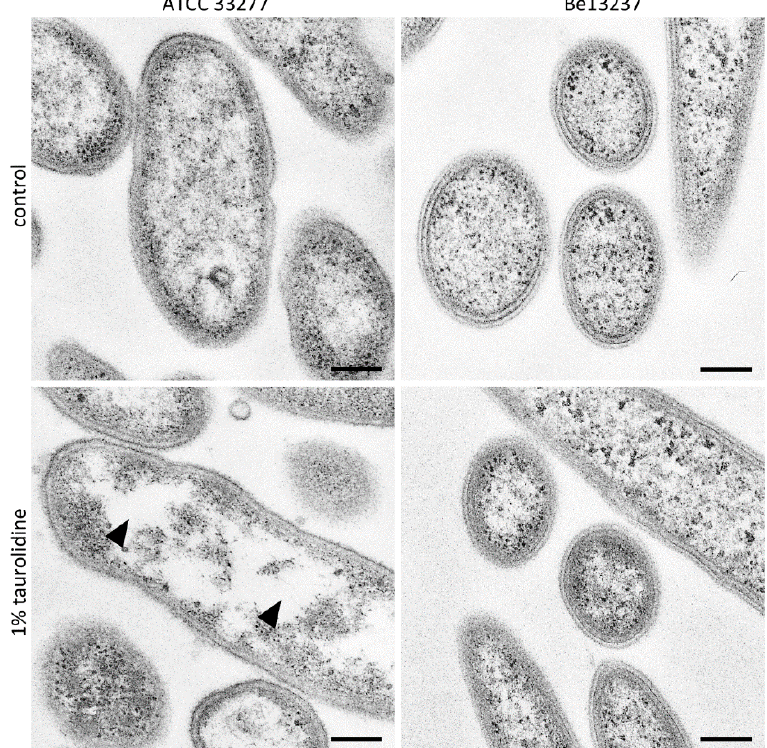
Figure 1. Transmission electron micrographs (TEM) images of Porphyromonas gingivalis ATCC 33277 and Tannerella forsythia Be13237 after treatment with 1% taurolidine for 2 h, in comparison to its control. P. gingivalis shows a decomposition of the cytoplasm leading to unstained areas (arrowheads). For T. forsythia, no difference could be found. Scale bars: 200 nm.